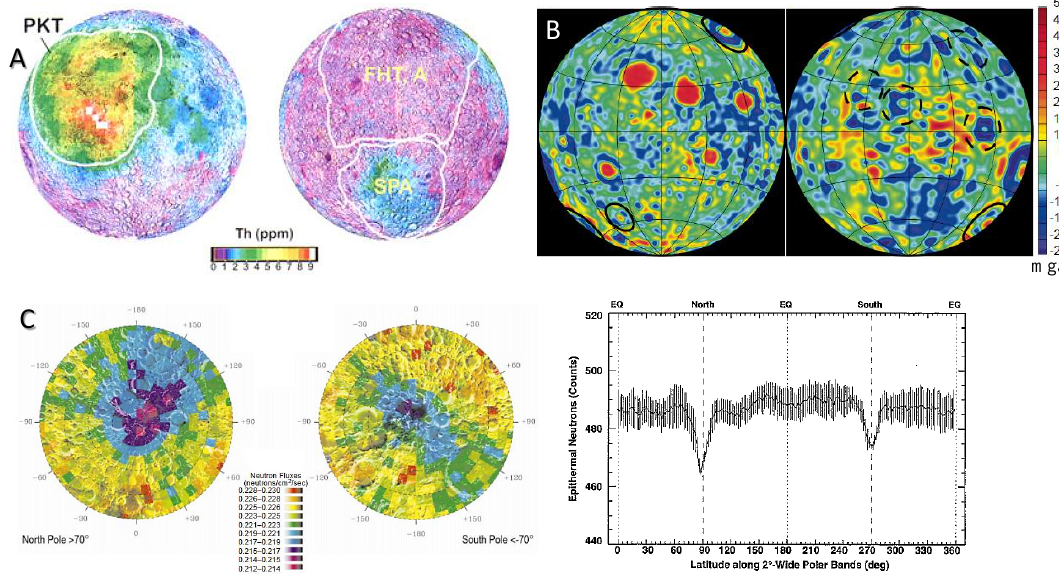
Figure 2. Scientific results from global lunar datasets. ( A ) Identification of major lunar terranes, their geologic context and scientific relevance (Source: [52]) . ( B ) Gravity signatures of the near and far side of the Moon obtained from Lunar prospector mission (Source: [59]) . ( C ) Polar maps of epithermal neutron fluxes measure by lunar prospector spacecraft, hinting at the presence of hydrogen-bearing species concentrated at the lunar poles and interpreted to be likely water-ice. The distinctive dips in epithermal neutron flux over poles highlighted the different character of neutron absorbers at the poles (Source: [56])